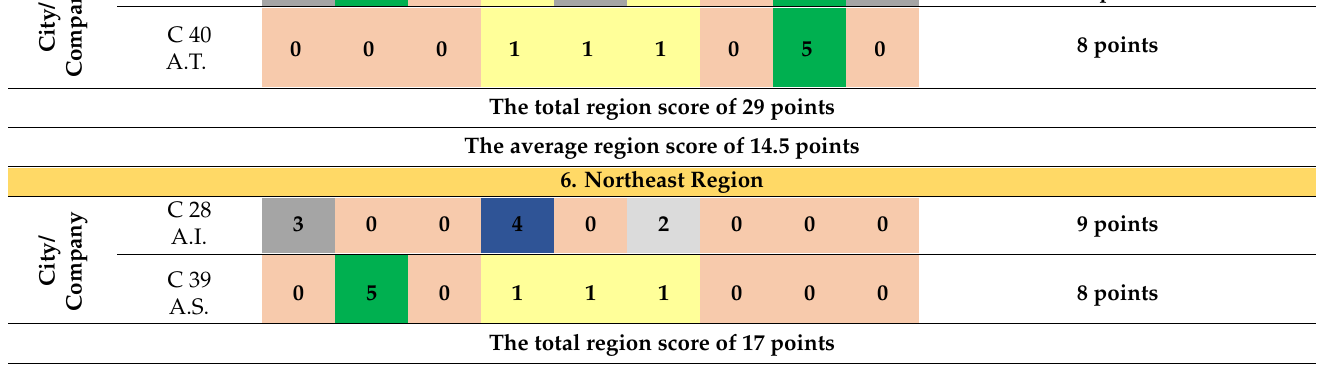
The total region score of 17 points The average region score of 8.5